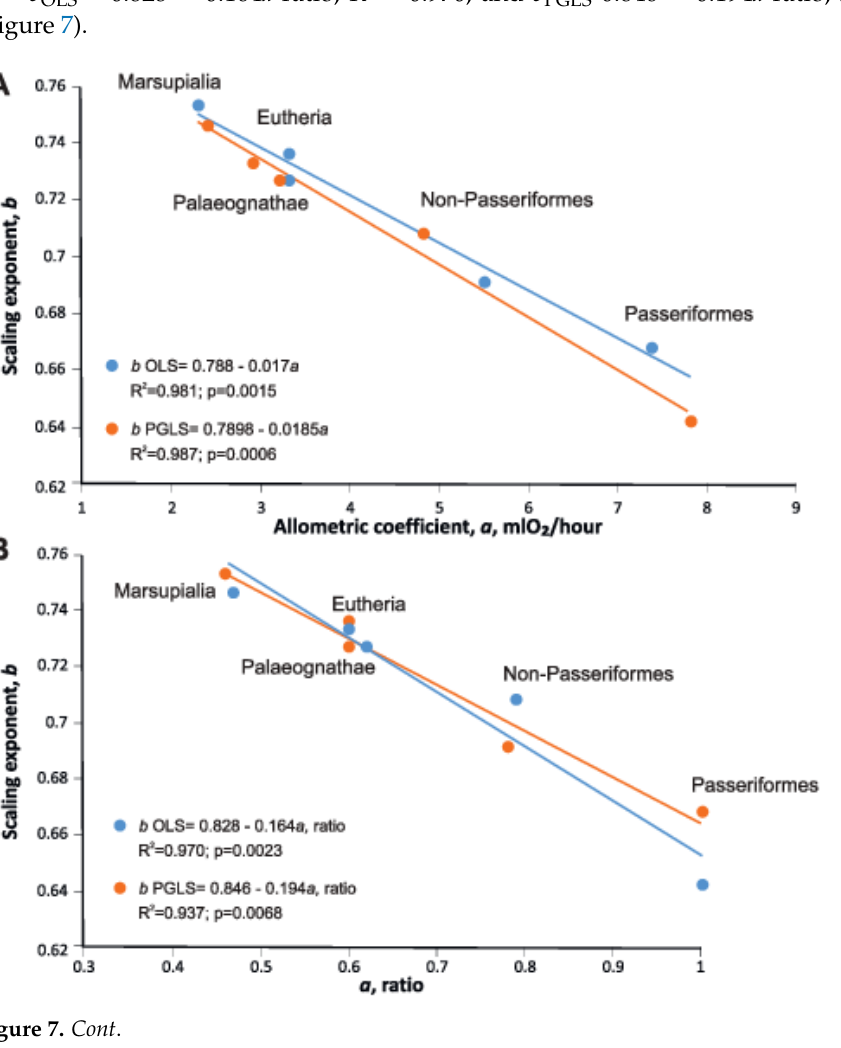
Figure 7. Dependence of scaling exponents on the allometric coefficients “ a ” (the level of metabolism) in five groups of endotherms: ( A ) “ a ” in ml O 2 /h per g. ( B ) “ a” (ratio). The scaling exponents and the allometric coefficients were obtained by the ordinary least squares model (OLS— blue line) and phylogenetic generalized least squares model (PGLS—yellow line). ( C ) Dependences of the scaling exponents on the level of metabolism a measure of scaling elevation, L, which is log (BMR/m) at the pivotal midpoint of a log–log scaling relationship) in five groups of endotherms. 4. Discussion We have characterized the long-term evolutionary dynamics of the metabolic scaling relationships, in relation to the development of endothermic animals and endothermy proper. Despite the considerable history of discussion of metabolic scaling, as well as the substantial number of empirical tests, the available data show that there is not one scaling pattern, but a diversity of patterns. Different groups, data sets, standardizations, and analytical approaches have provided different answers [1–5,7,8,10,12–22]. The association of scaling parameters with evolutionary age has been studied by Zotin et al. [24,28], Atanasov and Dimitrov [29],